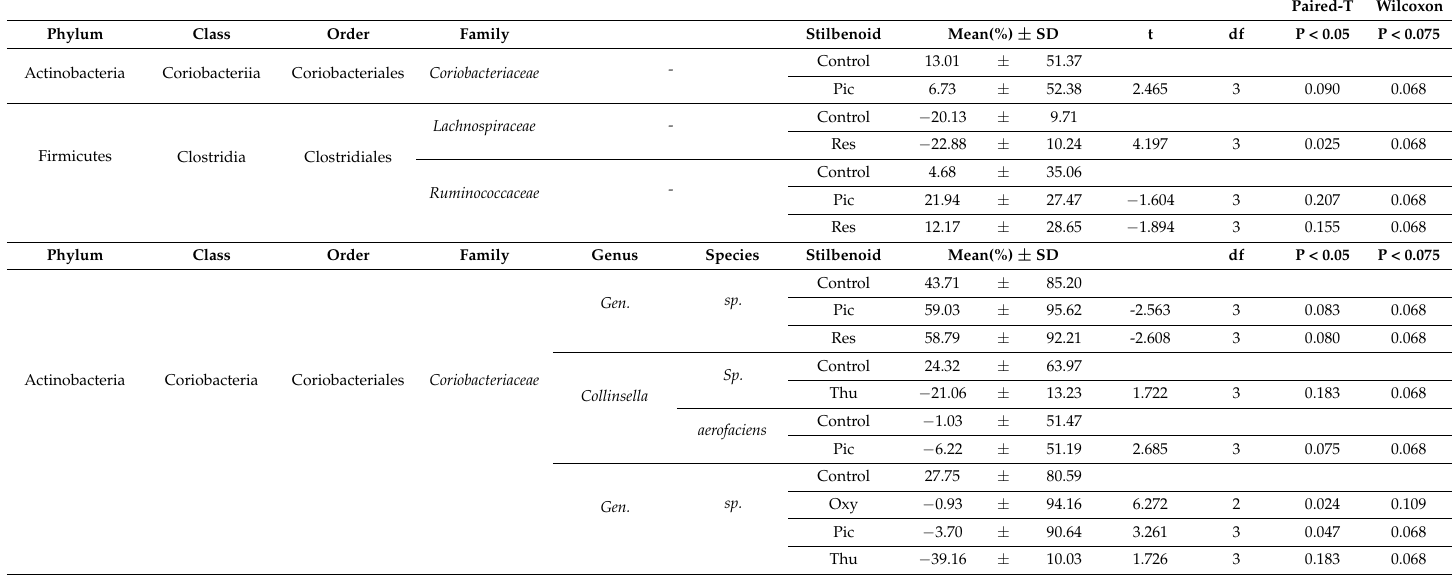
Table A4. Identified taxa based on Comparison 2, which used as a baseline the magnitude of change (growth or decline) in relative abundance between Control 0 h and Control 24 h, and compared that to the magnitude of change between Control 0 h and each of the 6 stilbenoid fermentations. Taxa displayed Paired-T p value <0.05 and/or Wilcoxon Signed Rank p value <0.075. Bolded values are those within these ranges. Gen. = unnamed genus, sp. = unnamed